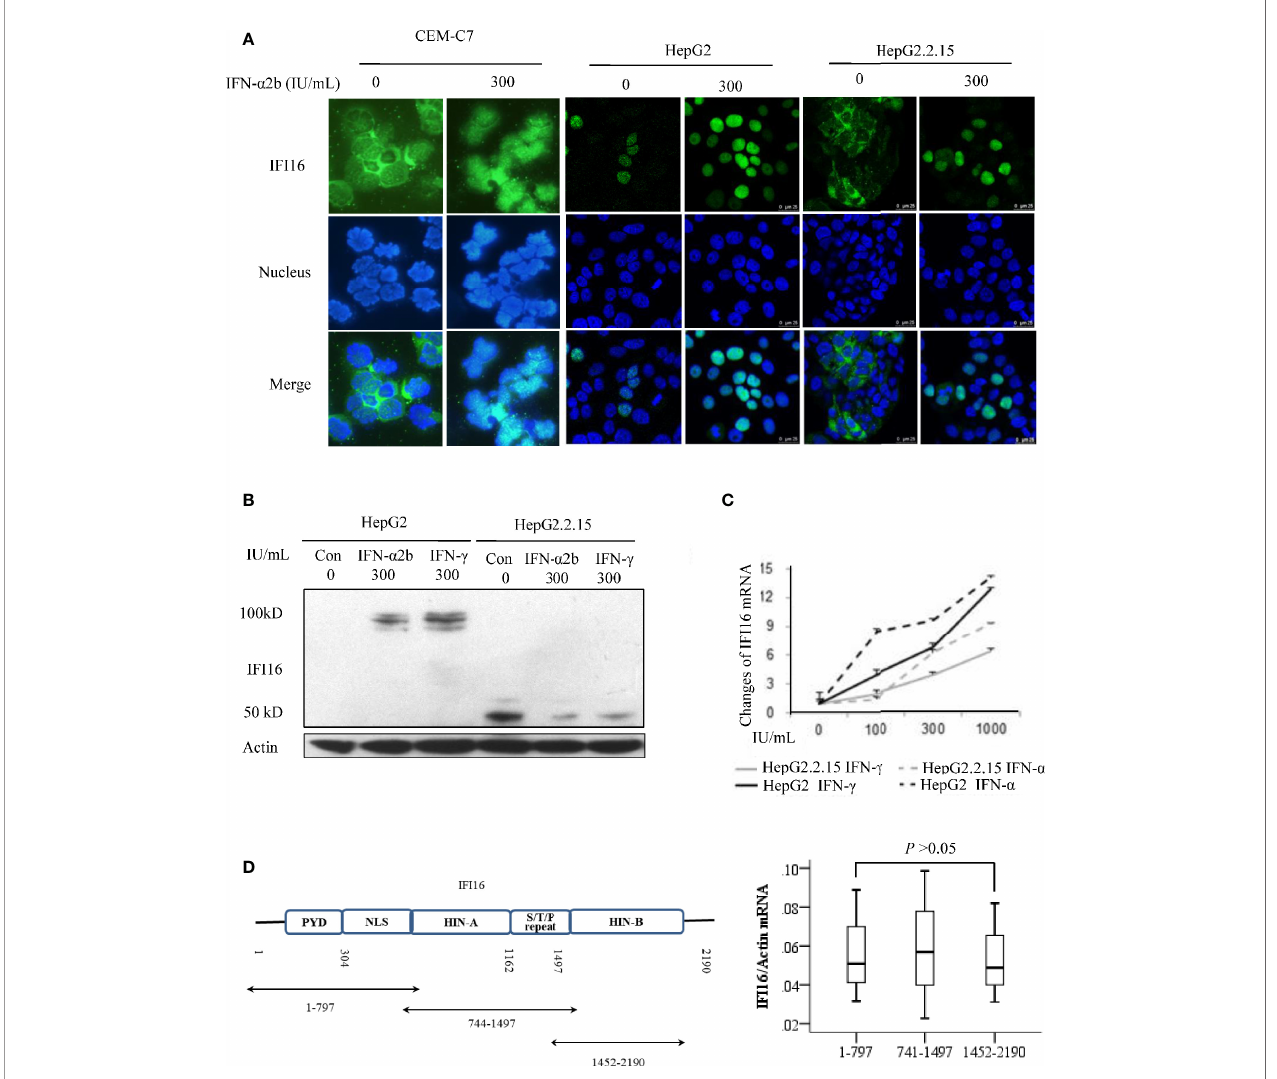
FIGURE 4 | Interferon enhances expression, promotes translocation, and inhibits degradation of IFI16. Immuno fl uorescent staining for detecting the subcellular distribution of IFI16 in the CEM-C7, HepG2, and HepG2.2.15 cells after 2 days of IFN- a 2b treatment. DAPI was used for indicating nucleus (A) . IFI16 protein (B) and IFI16 mRNA (C) in HepG2 and Hep2.2.15 cells after 2 days of IFN- a 2b or IFN- g treatment. The RT-qPCR analysis of overlapping segments of IFI16 mRNA in HepG2.2.15 cells. The difference was tested by performing a Mann-Whitney U test (D)